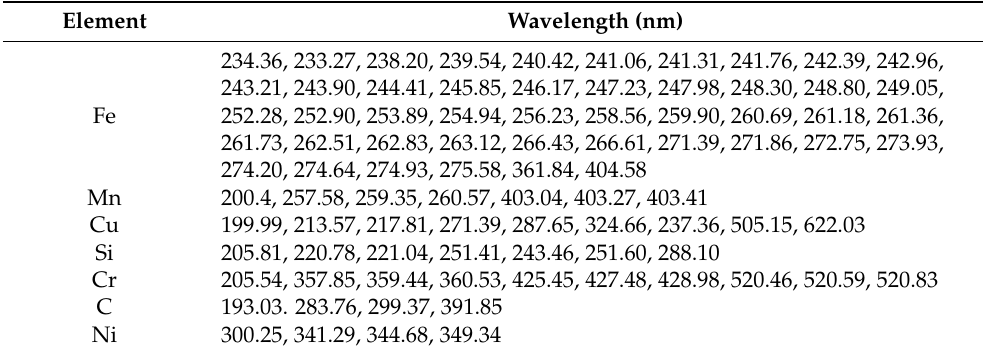
Table 3. Corresponding specific wavelengths of the samples.